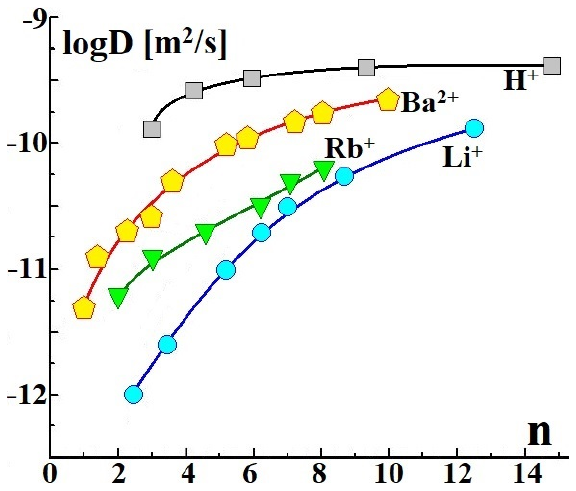
Figure 1. Dependences of diffusion coefficients of proton-containing groups (water self-diffusion coefficients) on hydration degree (number of water molecules per functional group) for perfluorinated sulfonic acid MF-4SK membranes in different ionic forms